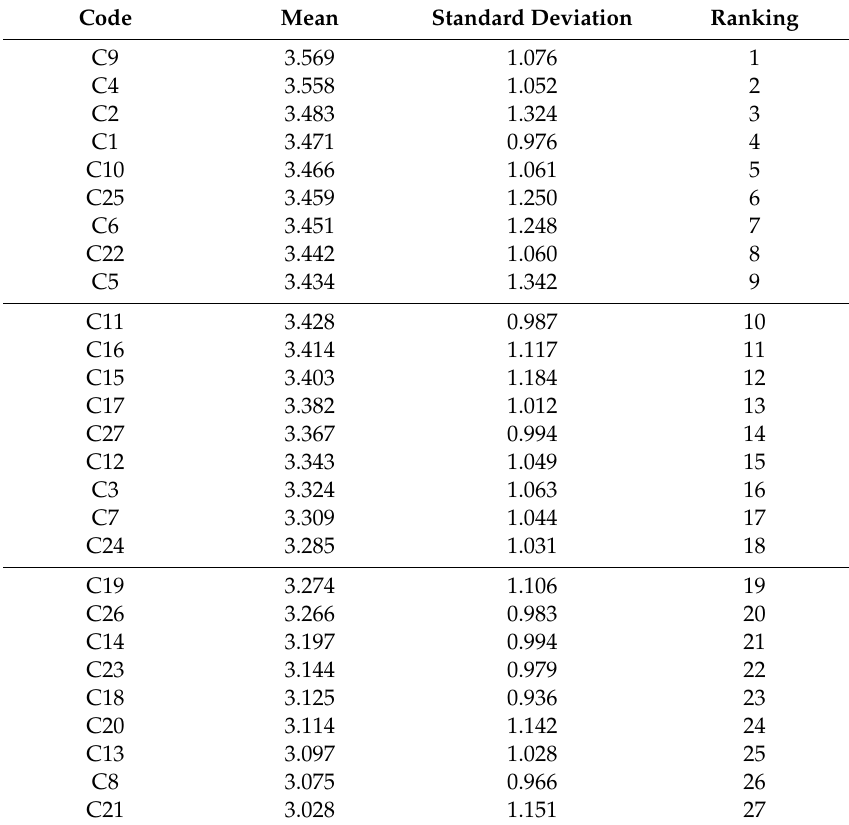
Table 5. Ranking of constraints hindering modular